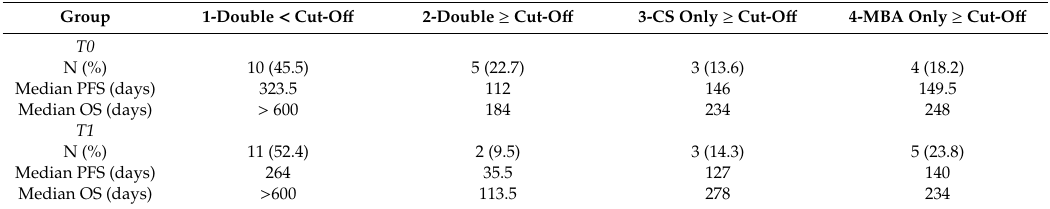
Table 5. PFS and OS according to the combined application of the metabolism-based assay (MBA) and CellSearch